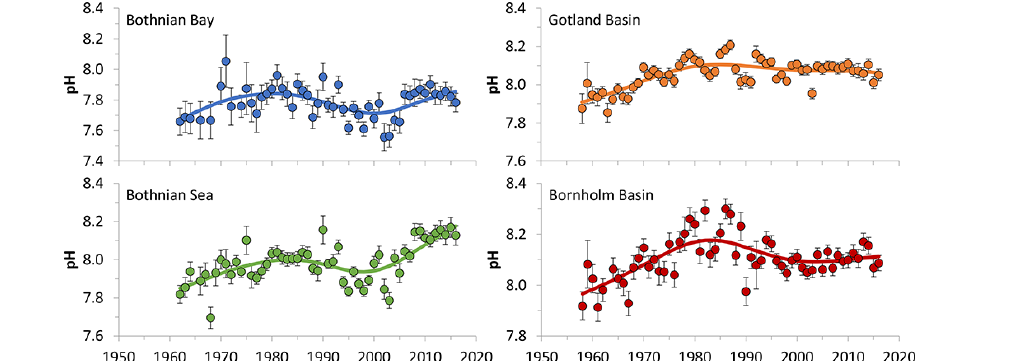
Figure 9. Trends in surface (0–10m) pH T (recalculated from NBS) for four major Baltic Sea basins, adopted from Carstensen and Duarte (2019, their Suppl.